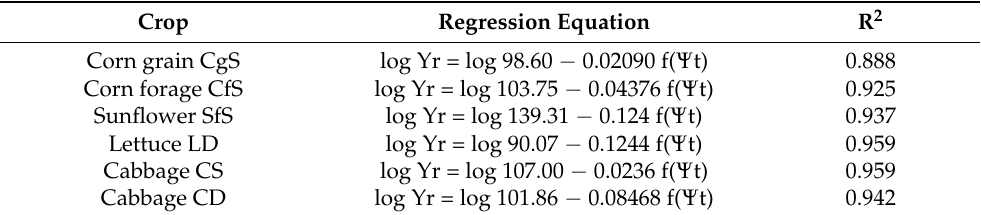
Table 9. Regression analysis of the relationship between the relative yield Yr (%) of several irrigated crops and the function of the soil total water potential f( Ψ